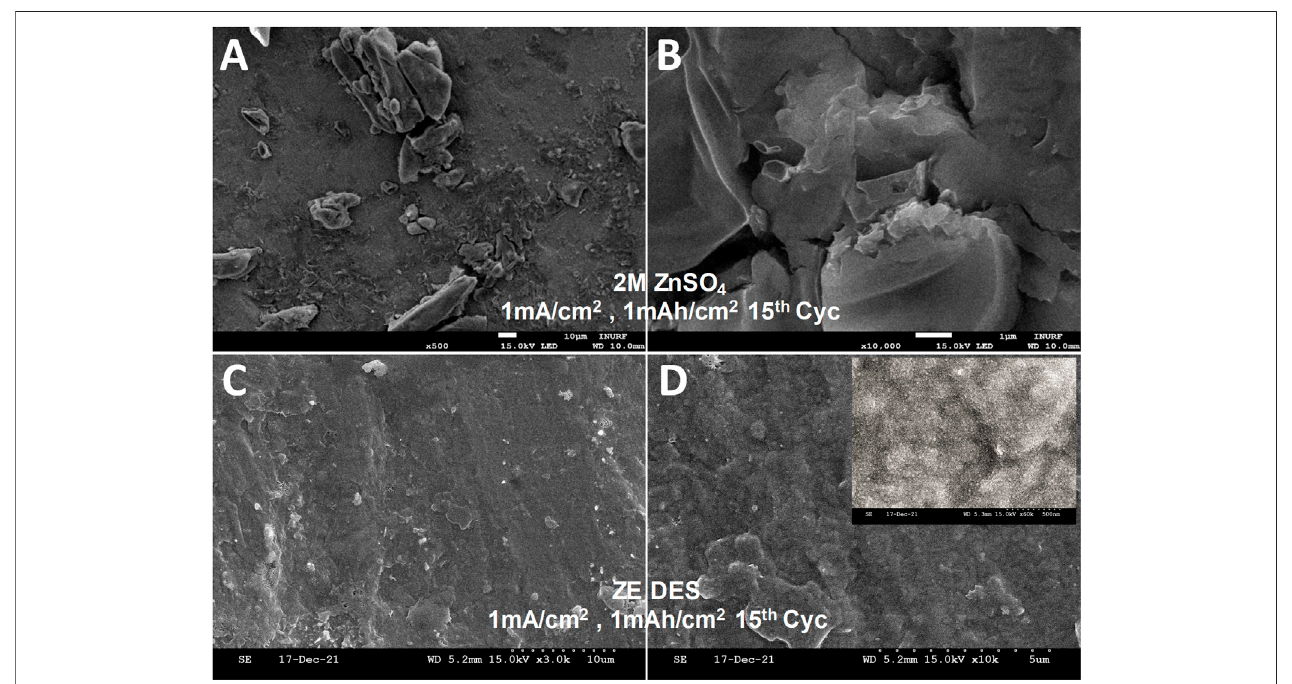
FIGURE 8 | SEM images of Zn metal anode (A,B) 2 M ZnSO 4 electrolyte ZE electrolyte; (C,D) ZE electrolyte after 15 cycles at 1 mAh cm − 2 .